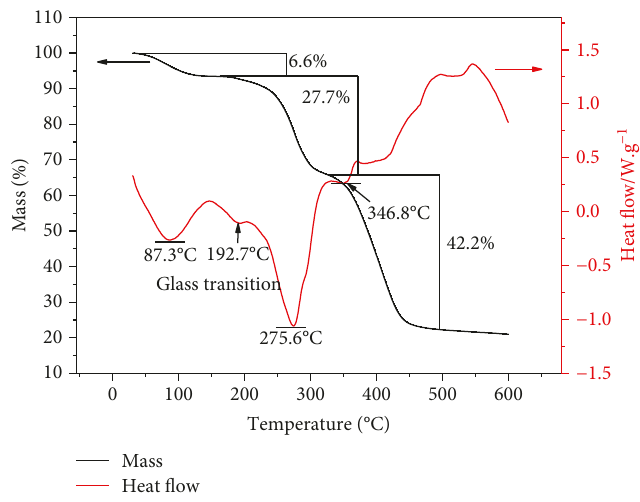
Figure 9: Thermogravimetric curve of PAD.